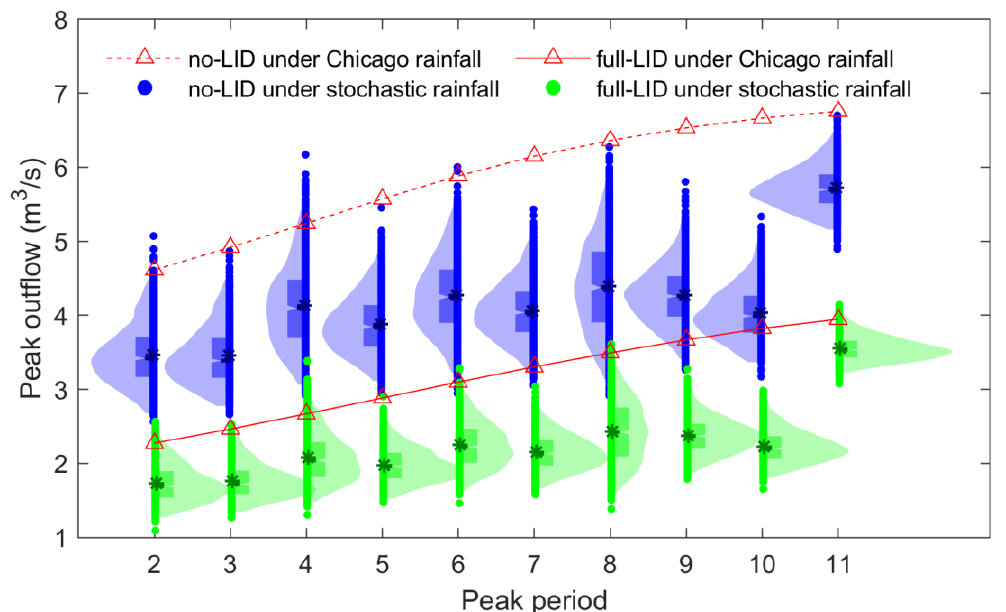
Figure 6. Catchment peak outflow rate in no- and full-LID scenarios under Chicago and stochastic precipitation events with different peak periods. * represents the median.